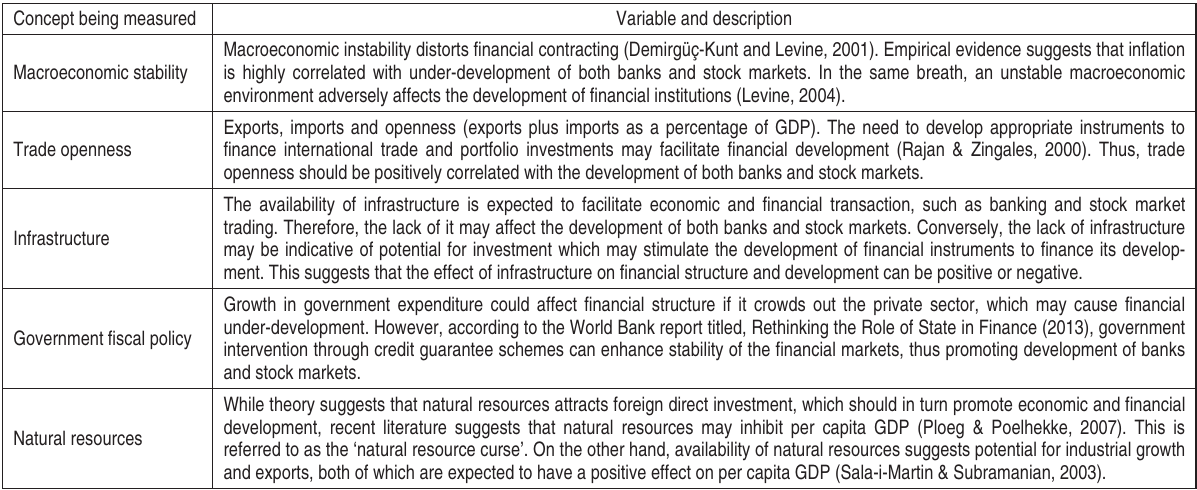
Table 1. Description of control variables Concept being measured Variable and